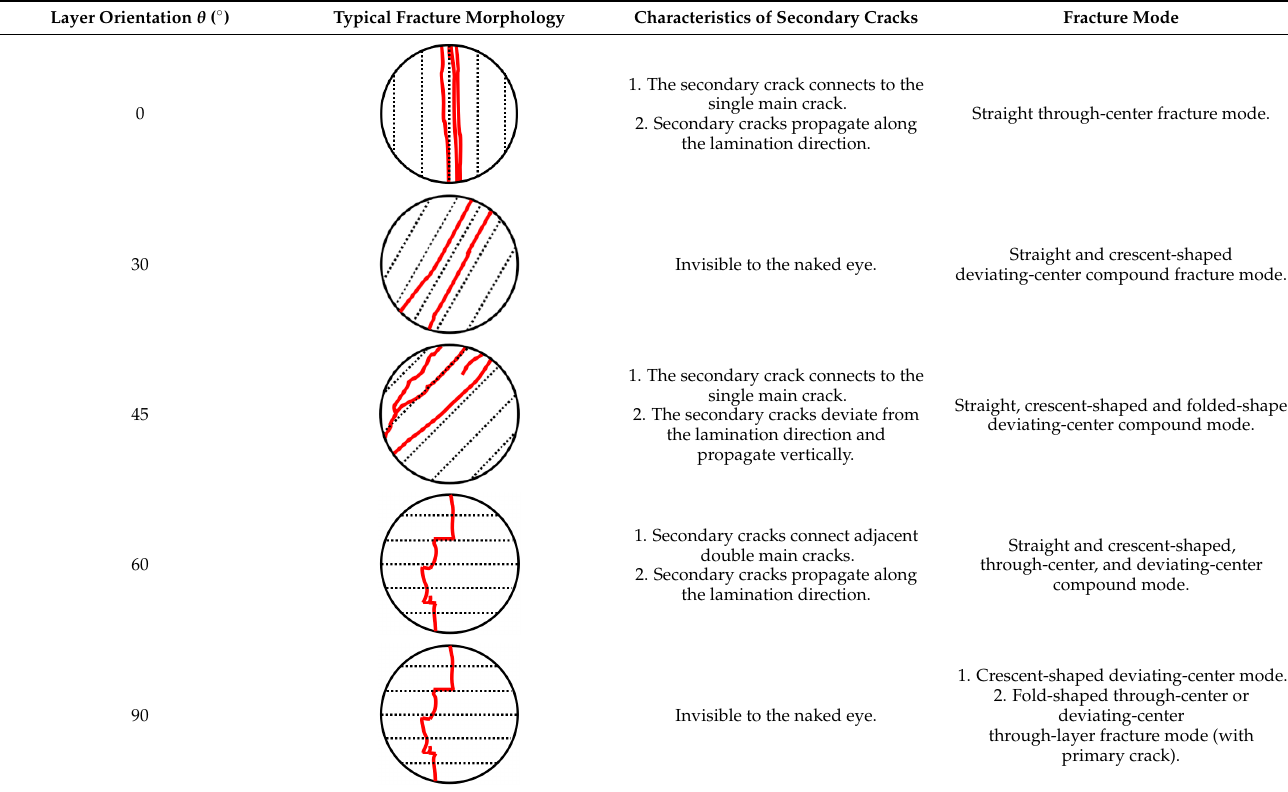
Table 5. Effect of layer orientation on fracture mode of continental shale.